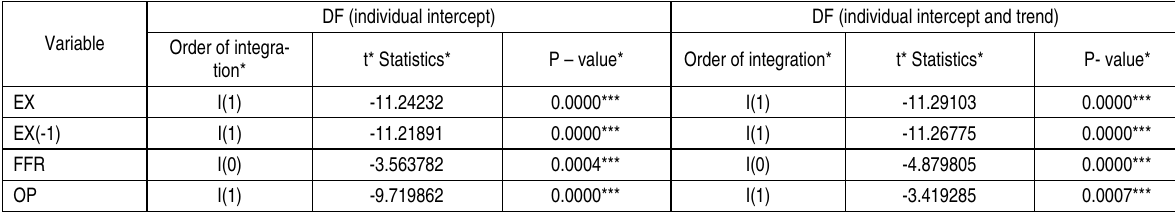
Table 1. The DF, ADF and P-P unit root tests for